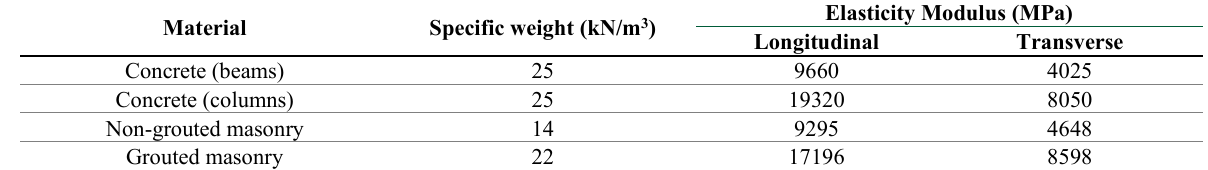
Table 1. Properties of the materials: equivalent frame model.